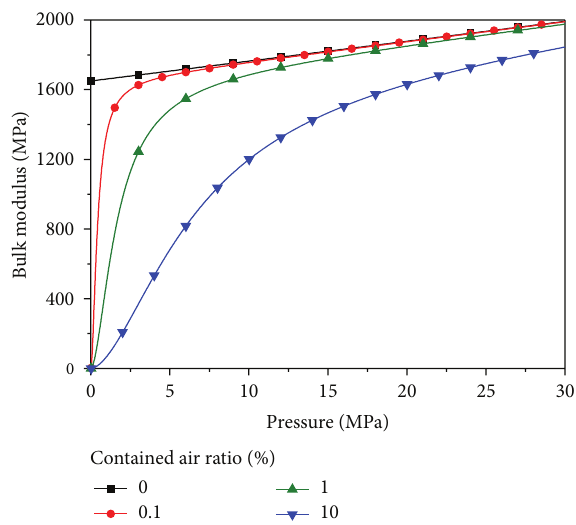
Figure 16: Example of the relationship between pressure and effective bulk modulus [12, 13].